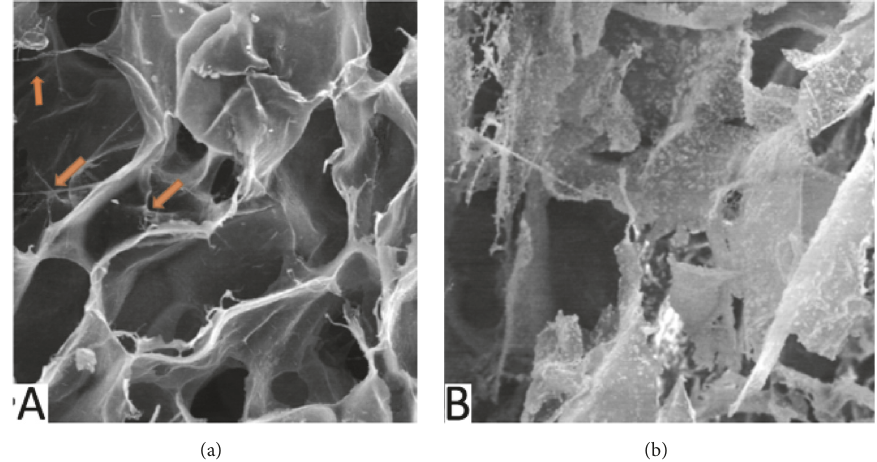
Figure 3: Cellular component in (a) SBCS group and (b) DSBCS group. Red arrow showed a cellular component of SBCS group.